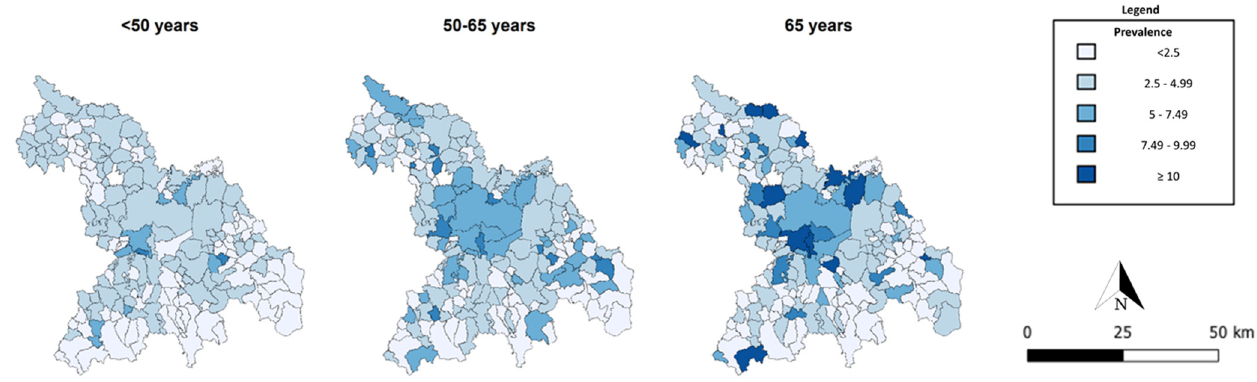
Figure A2. Choropleth maps of Alessandria LHA, divided by sex. Colors represent the percentage of positive NP swabs divided by the population, in turn stratified by groups.